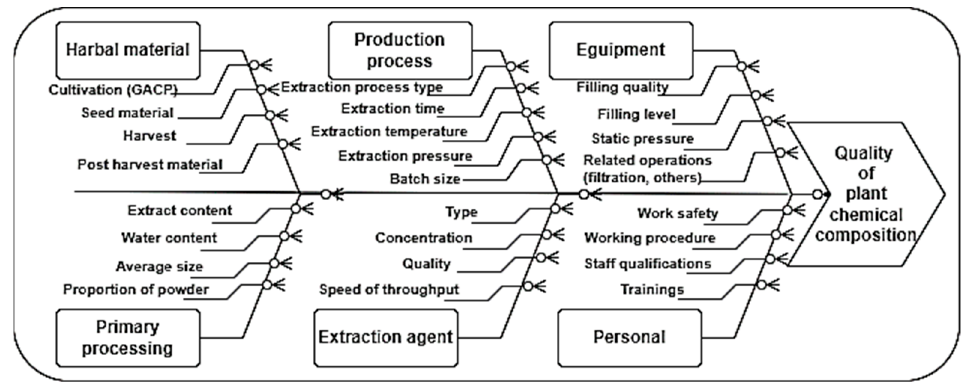
Figure 2. Risk assessment of C. sativus perianth extracts obtaining using the Ishikawa method.